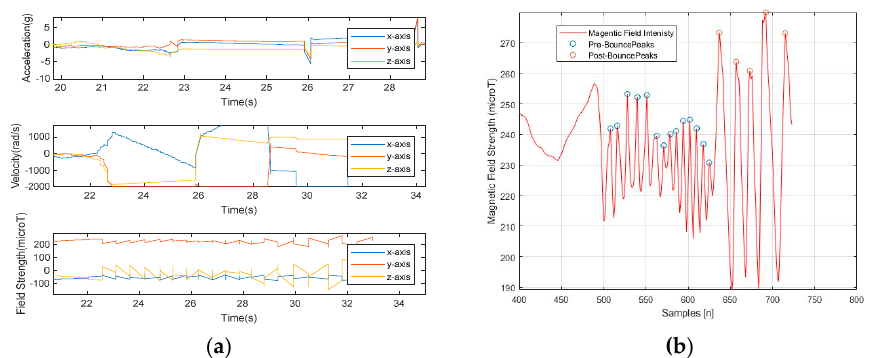
Figure 4. ( a ) IMU sensor readings of a spinning ball (acceleration—top, gyroscope—middle and magnetometer—bottom); ( b ) pre-bounce and post-bounce peaks of a spinning ball for the magnetometer.